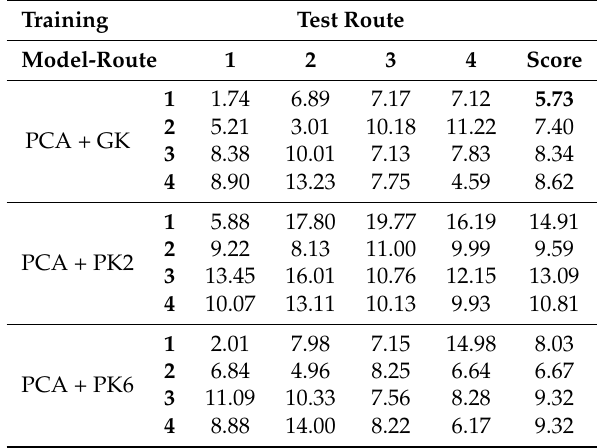
Table 5. MAEs of SVR PCA + GK, PCA + PK2 and PCA + PK6 models trained using four routes tested against the other